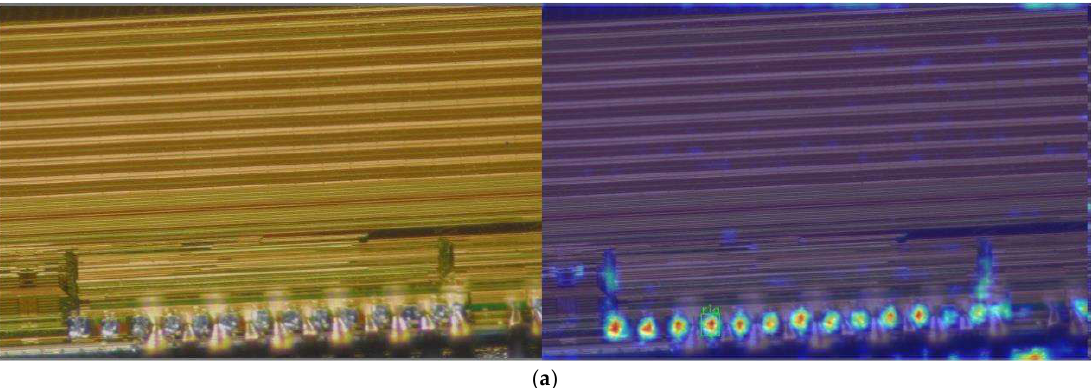
Figure 10. Comparison between our method and YOLOv5s model on-chip pad dataset. ( a ) Origin. ( b ) YOLOv5s. ( c ) Our.